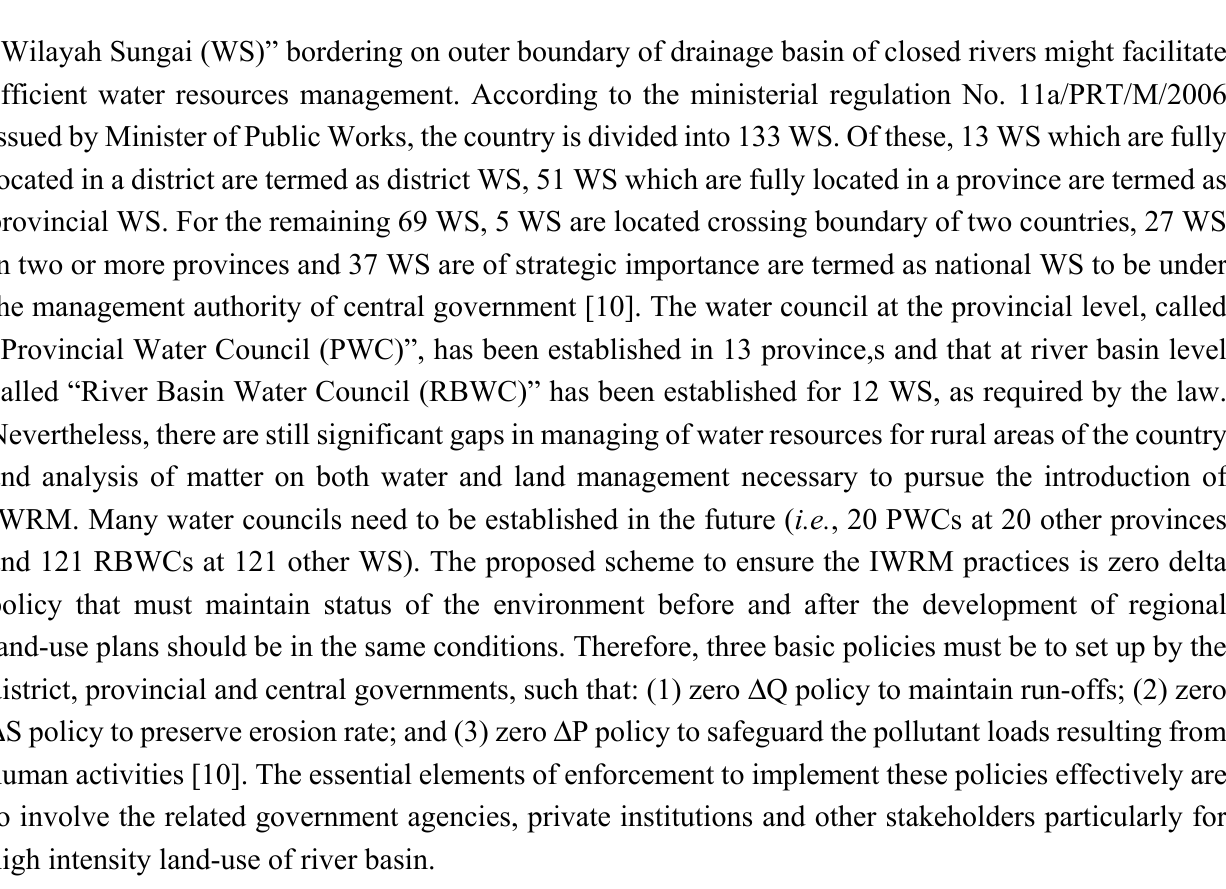
Figure 3. Elements of the future integrated water resources